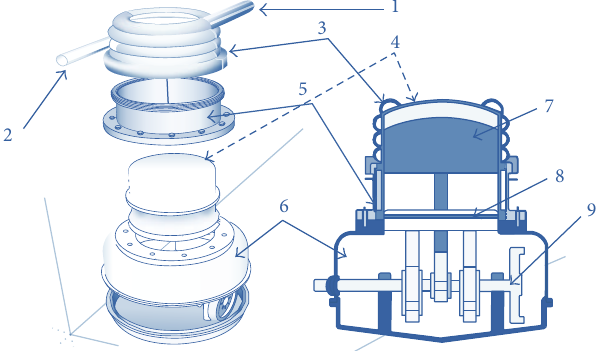
Figure 5: Exhaust’s heat recovery unit.